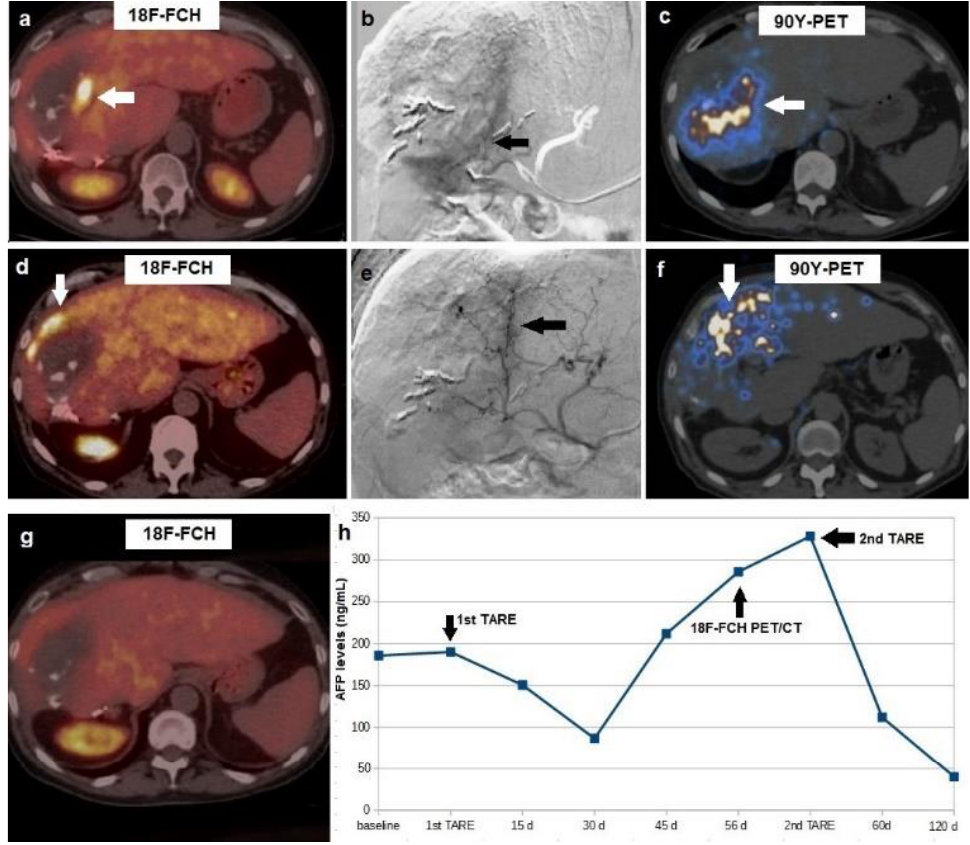
Figure 3. A 57-year-old male, affected by HCV-related cirrhosis and HCC in the right hepatic lobe, previously treated with laser ablation and surgical resection, referred to our center for 90 Y-TARE. ( a ) Pre-treatment 18 F-choline PET/CT demonstrated increased tracer incorporation in the infero-medial portion of the HCC lesion (arrow), which showed a central necrotic, hypodense area at co-registered CT slice. ( b ) Pre-TARE angiogram, performed after selective catheterization of the arterial feeder of the active tumor tissue detected by PET/CT, showed the hypervascularized tumor (arrow). ( c ) 90 Y-PET acquired 4 h after TARE demonstrated 90 Y-microsphere deposition in the treated tumor (arrow). ( d ) At 8-weeks post TARE PET/CT, a new-onset metabolically active HCC tissue was detected in the superior rim of the lesion (arrow), in spite of complete response of the tumor tissue previously located in HCC’s infero-medial portion. Therapeutic decision was to carry out a second 90 Y-TARE: ( e ) a new angiogram was acquired after selective catheterization of the arterial branch for the upper hepatic segments (arrow). ( f ) 90 Y-PET at 4 h post TARE demonstrated 90 Y-microsphere accumulation in the superior portion of the HCC lesion. ( g ) Post-treatment PET/CT at 8 weeks after the second 90 Y-TARE showed complete metabolic response. ( h ) Graph representation of alphafetoprotein trend during the different phases of the patient’s clinical management. Overall survival was 25 months.